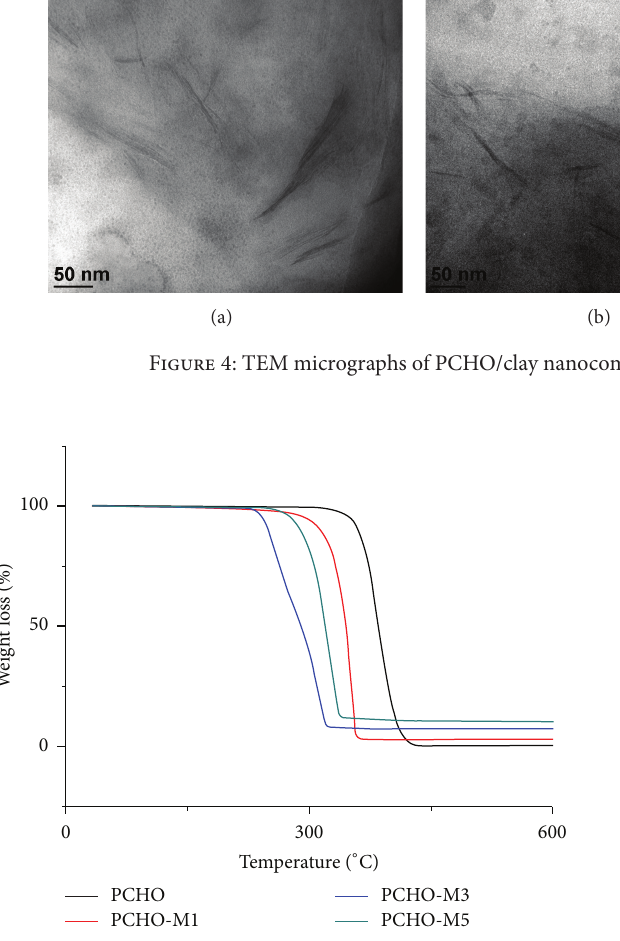
Figure 5: TGA diagram of pure polymer and nanocomposites.